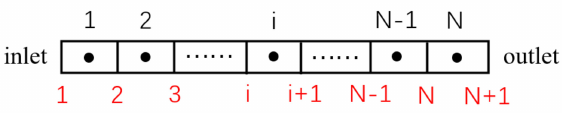
Figure 7. Staggered